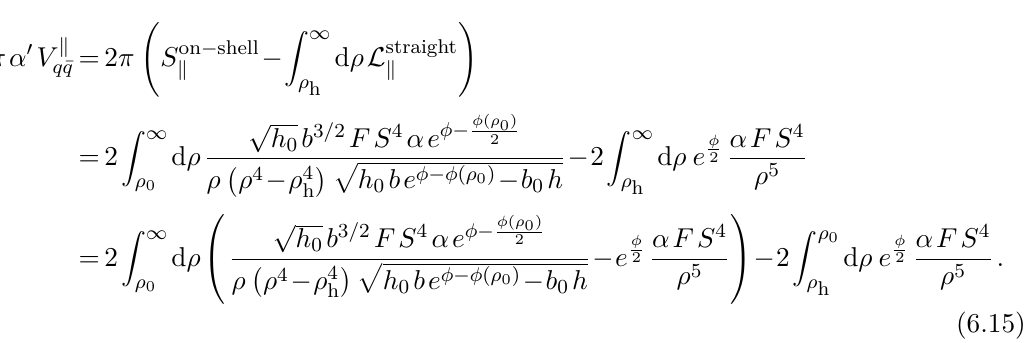
Figure 2 . Quark-antiquark potential ˜ V a plots are for different (cid:15) and fixed ˜ δ , while the lower ones correspond to different values of ˜ δ and fixed (cid:15) . The left plot shows the intra-layer potential, while the right one is the inter-layer one.